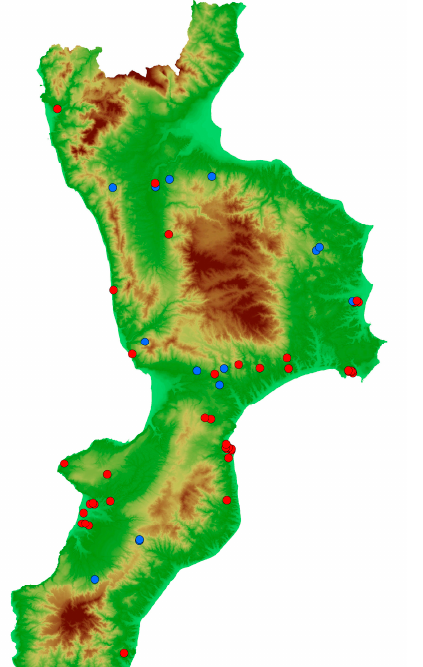
Figure 8. Distribution of phytotoponyms related to Quercus pubescens s.l. on map and by altitudinal belt. Blue, agreement with current forest vegetation; red, no agreement.